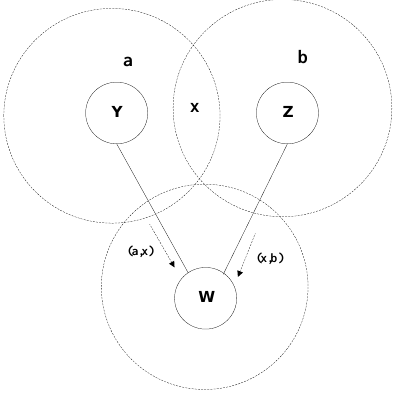
Figure 3. The overlap problem. Y & Z sensor nodes are overlapping geographic region (at x). Node W gets same of copy of overlapped